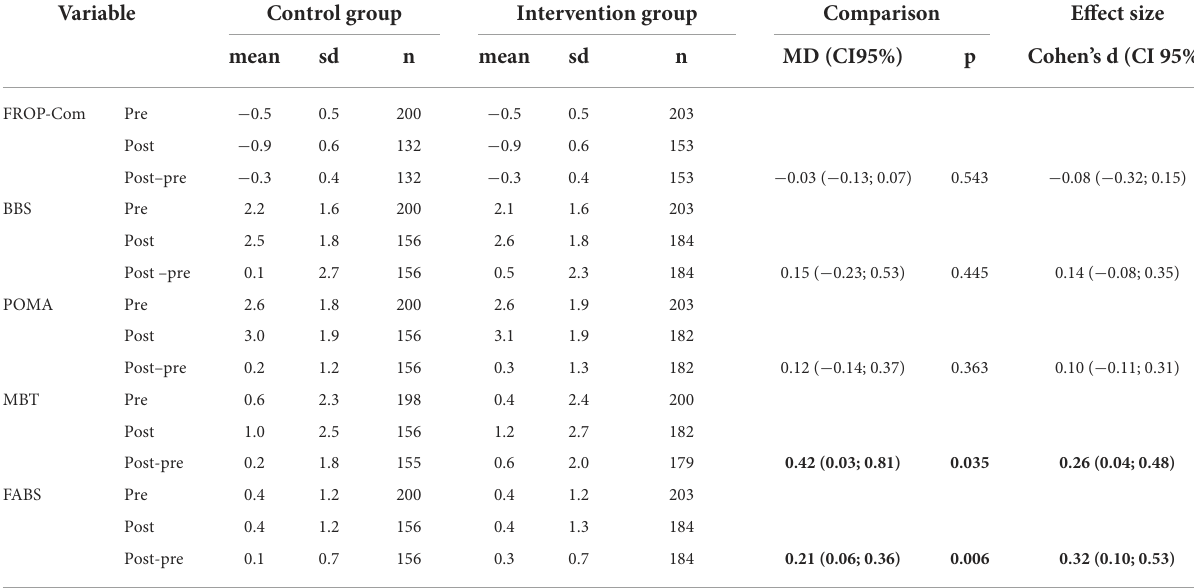
TABLE 8 Analysis of pre-test vs. post-test differences for FROP-Com and balance indicators. Variable Control group Intervention group Comparison Effect